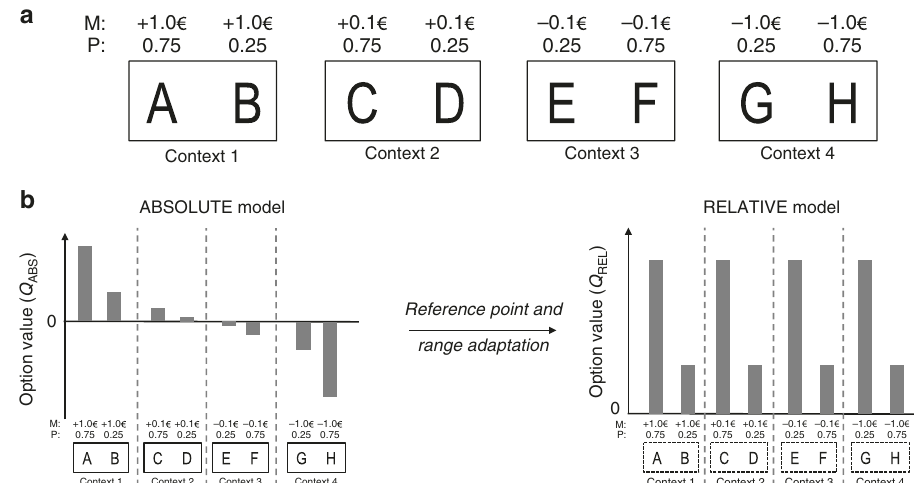
Fig. 1 Experimental design and normalization process. a Learning task with four different contexts: reward/big, reward/small, loss/small, and loss/big. Each symbol is associated with a probability ( P ) of gaining or losing an amount of money or magnitude ( M ). M varies as a function of the choice contexts (reward seeking: + 1.0 € or + 0.1 € ; loss avoidance: − 1.0 € or − 0.1 € ; small magnitude: + 0.1 € or − 0.1 € ; big magnitude: + 1.0 € or − 1.0 € ). b The graph schematizes the transition from absolute value encoding (where values are negative in the loss avoidance contexts and smaller in the small magnitude contexts) to relative value encoding (complete adaptation as in the RELATIVE model), where favorable and unfavorable options have similar values in all contexts, thanks to both reference-point and range adaptation